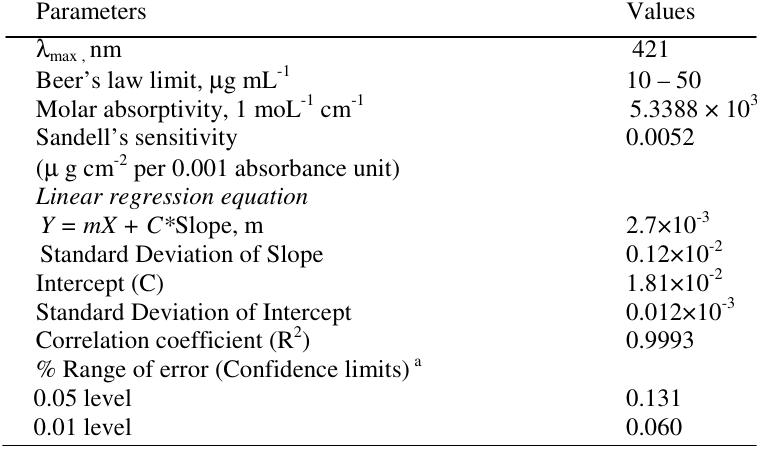
Figure 3 . Effect of pH on the absorbance of OXA (30 µ g mL -1 ) - BCG (1 mL of 0.12% (w/v). Table 1. Optical characteristics, precision and accuracy of the propose method